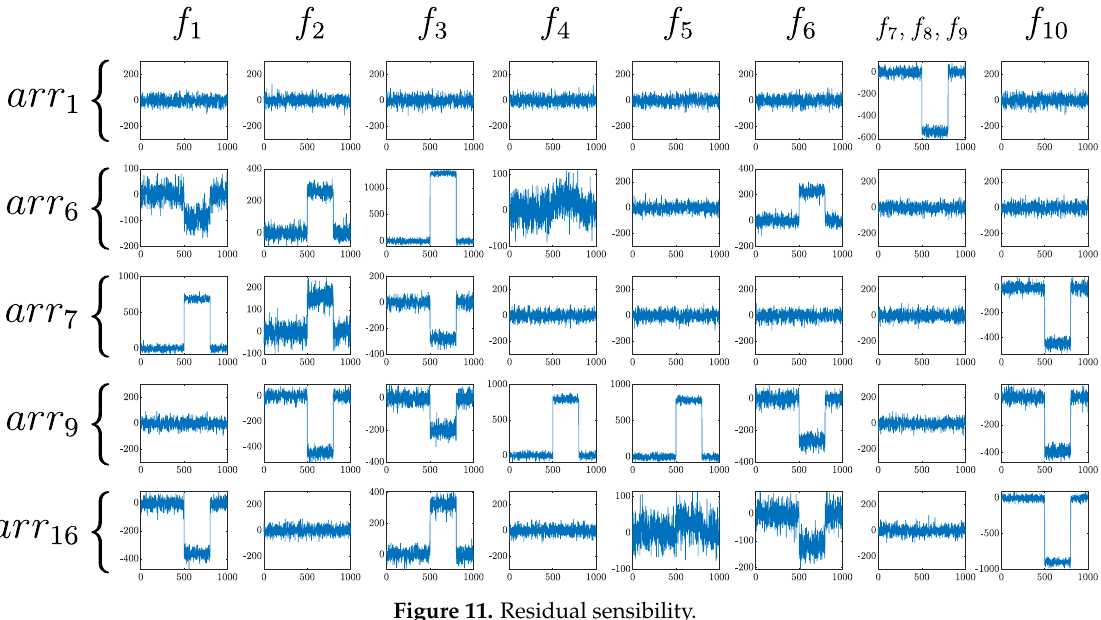
Figure 11. Residual